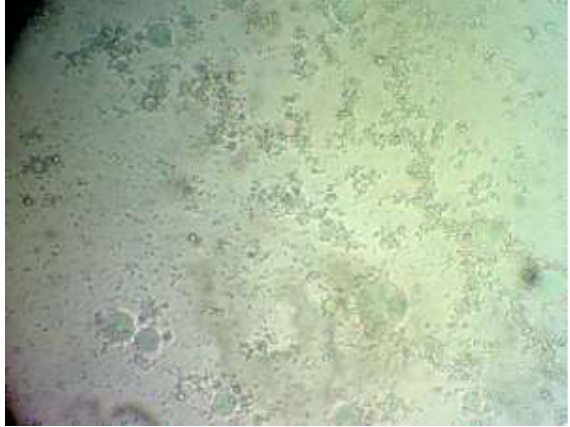
Figure 2: Direct examination of the gills spores of Branchiomyces spp.